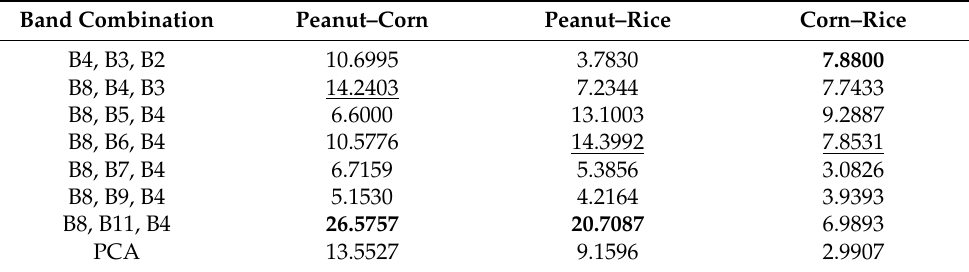
Table 3. The average distance of three crops (corn, peanut, and rice) in CIELab Color Space under different band combinations. The optimal accuracies are boldened, and the sub-optimal accuracies are underlined. The last row of the table features the PCA results. B1 represents Band 1 in the table. Band